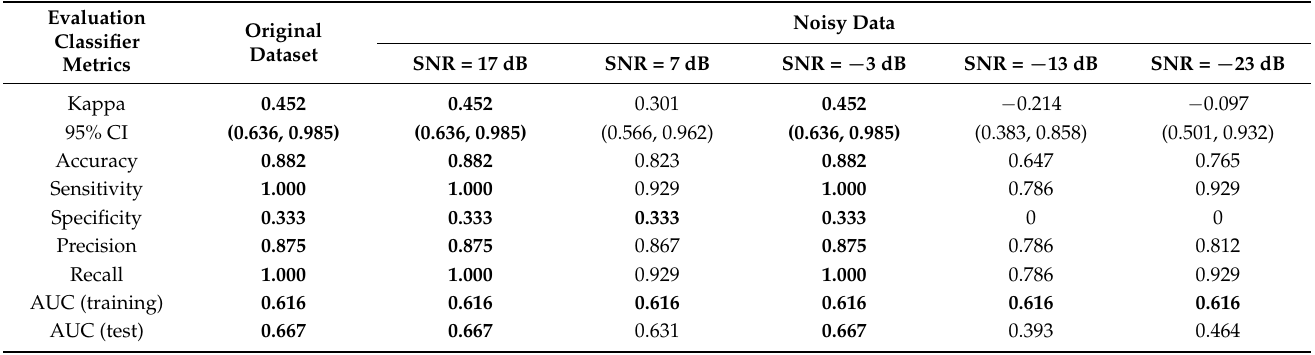
Table 3. ML evaluation parameters for binary RF classification of nausea for original and noisy data. The best results are presented in bold. SNR stands for Signal-to-Noise Ratio, CI stands for Confidence Interval, and AUC stands for Area Under the Curve. Two AUC values are presented for the validation set and for the test set 1 .